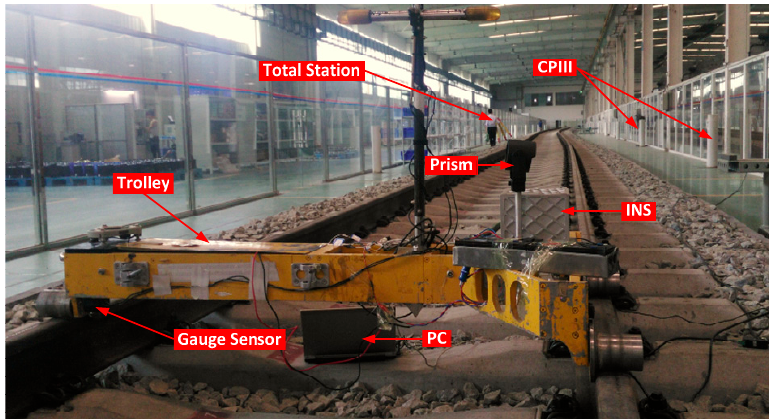
Figure 13. The experimental railway line and the measurement system. Sensors 2017 , 17 , 2083